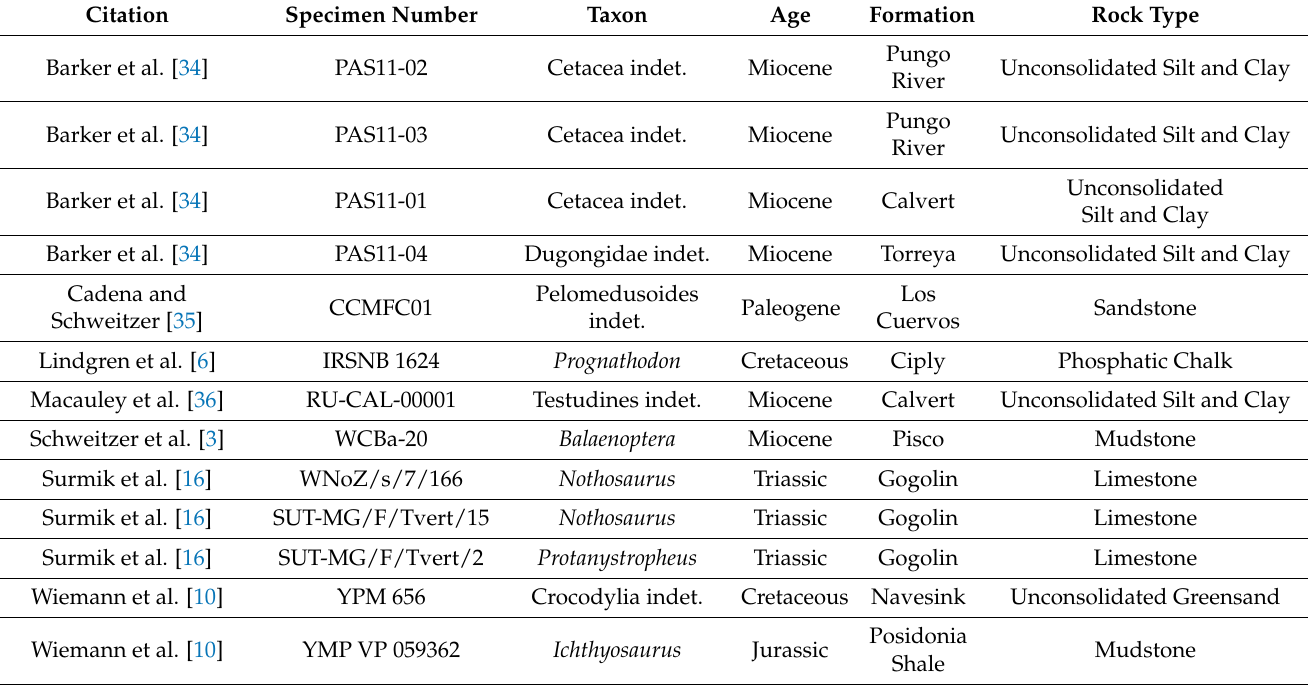
Table 1. Summary of fossil specimens collected from marine sediments that have previously been examined for cellular and/or soft tissue preservation by